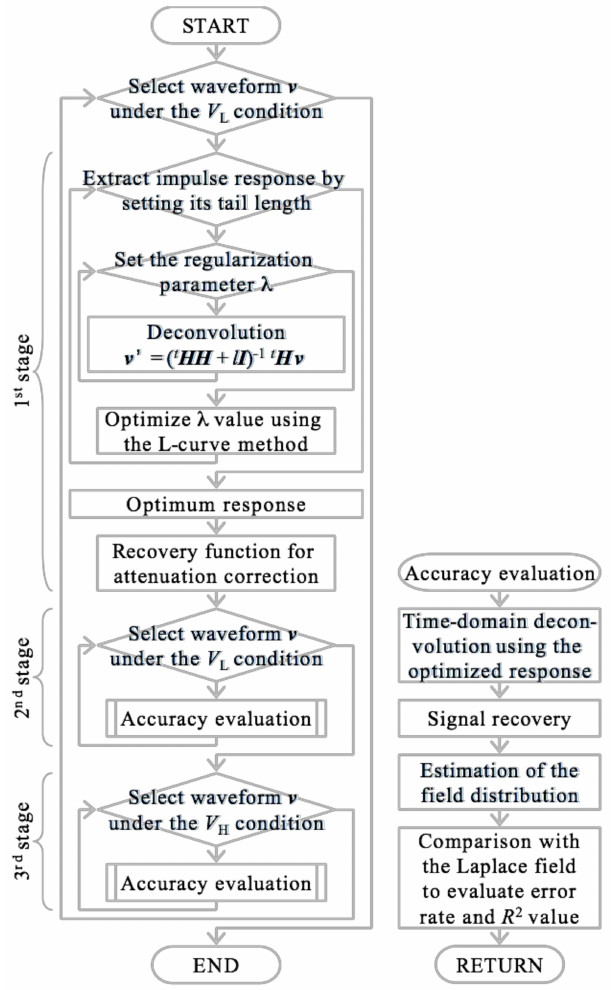
Figure 2. Flowchart for evaluating the analysis